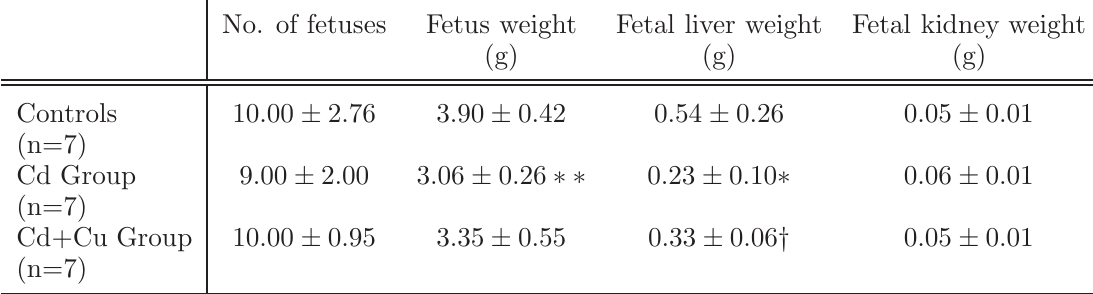
Table 2 Comparisons of number of fetuses and fetal tissue weights (mean ±